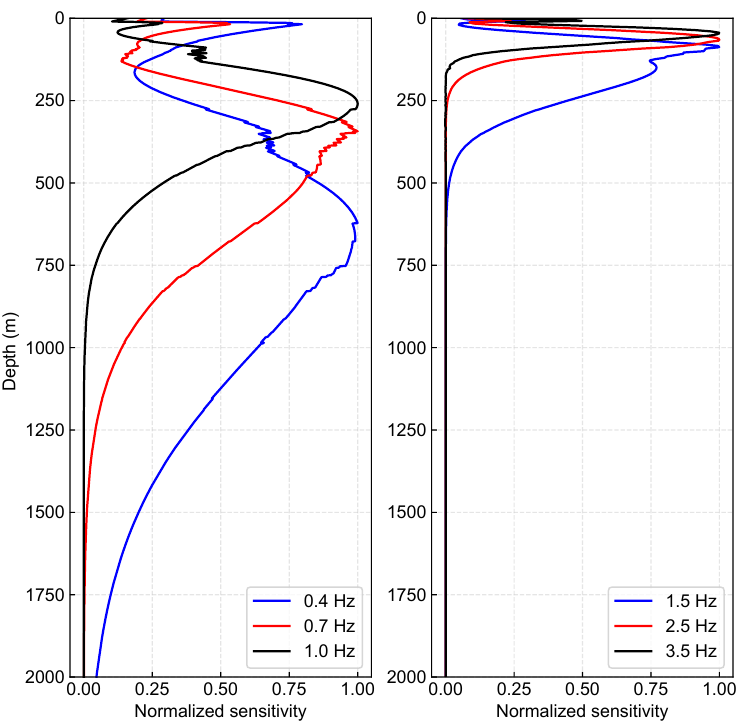
Figure 11. Normalized depth sensitivity kernels for different frequencies of surface